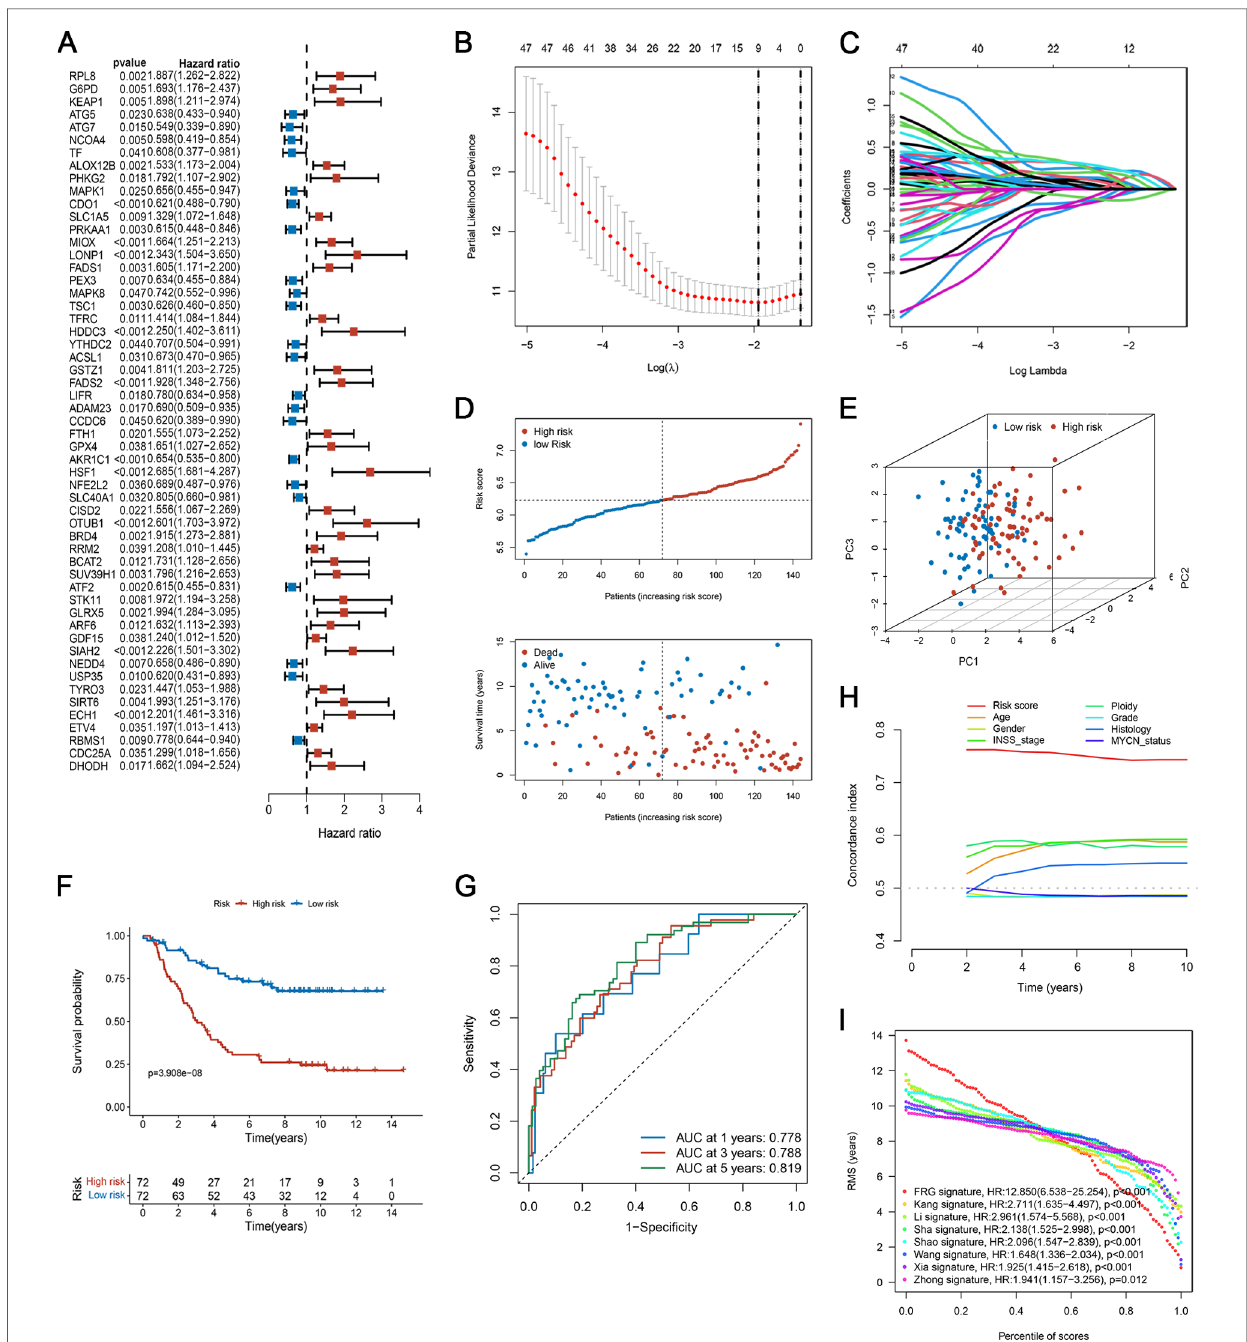
FIGURE 4 Development of the ferroptosis-based prognostic model in the training set. ( A ) Forest plot of FRGs related to overall survival, analyzed by univariate Cox regression. ( B ) Plots of the ten-fold cross-validation error rates. ( C ) The spectrum of LASSO coef fi cients of the nine FRGs. ( D ) The survival distribution of patients in the training focus increased patient mortality with the increase in risk score. ( E ) PCA showed remarkable differences between the two risk groups. ( F ) Kaplan-Meier survival curve between the two risk subgroups. ( G ) TdROC curve based on risk scores. ( H ) C-index of the risk score and clinical traits. ( I ) RMS curves for the composite prognostic signature and other clinical